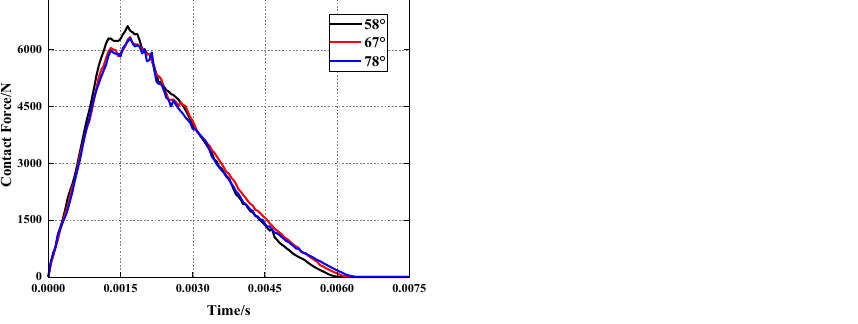
Figure 12. Comparison of the contact force history of the impactor under different concave angles.